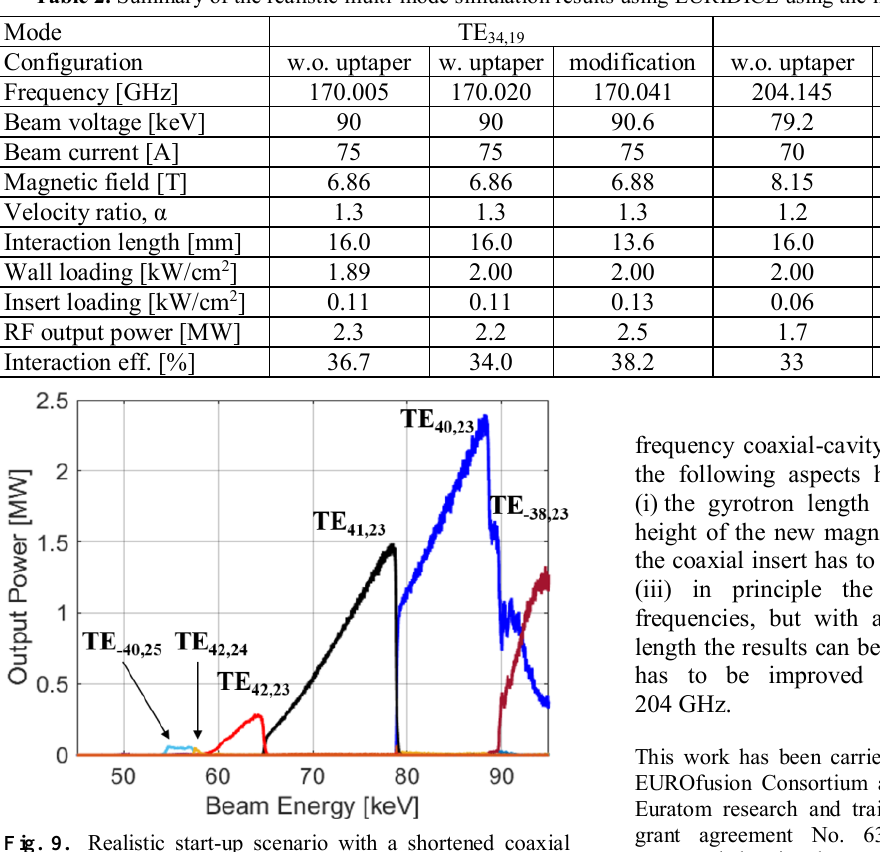
Fig. 9. Realistic start-up scenario with a shortened coaxial cavity midsection length at 8.23 T and I beam = 75 A.